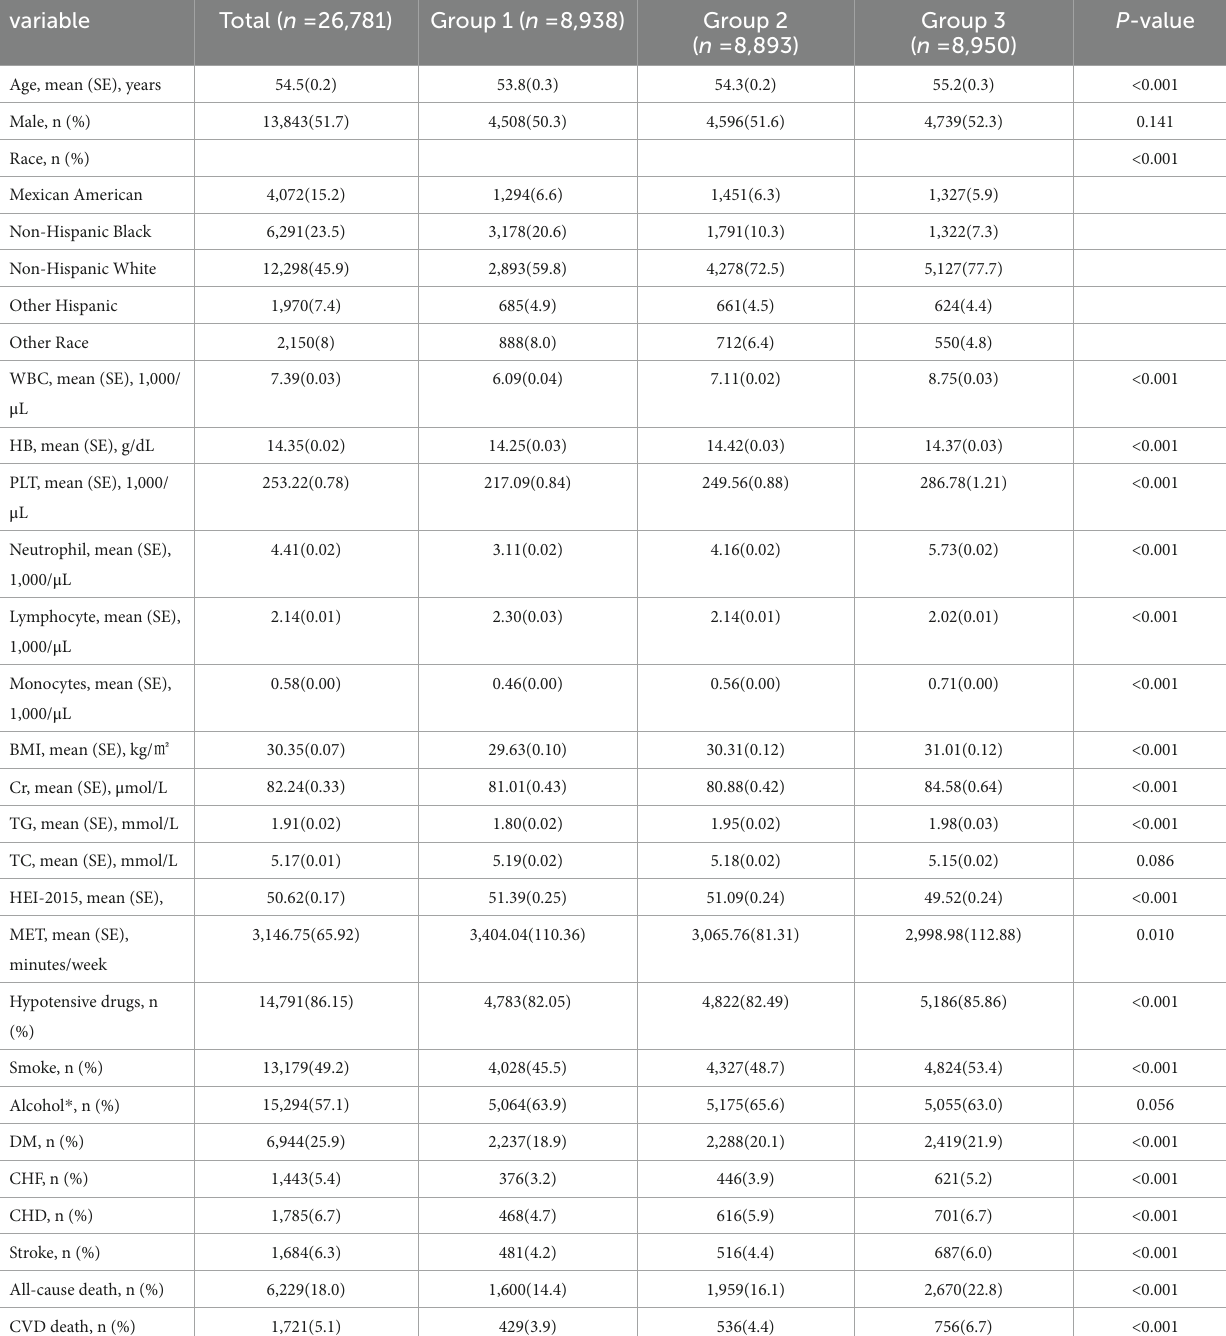
TABLE 1 Baseline study population characteristics